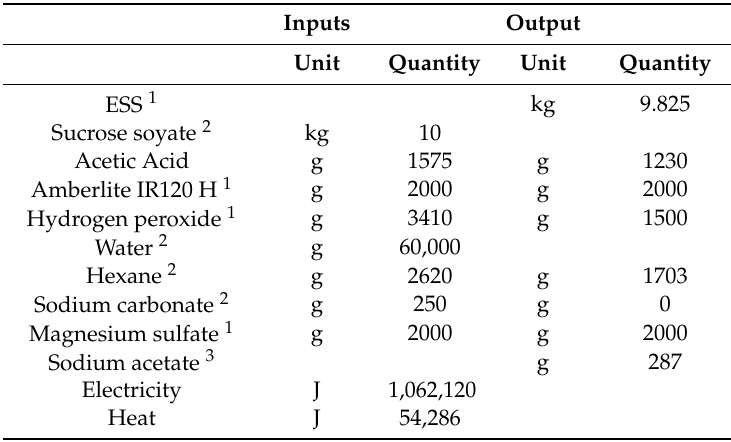
Figure 2. Epoxidation process of sucrose soyate [15]. Table 1. LCI data for 10 kg of ESS production.